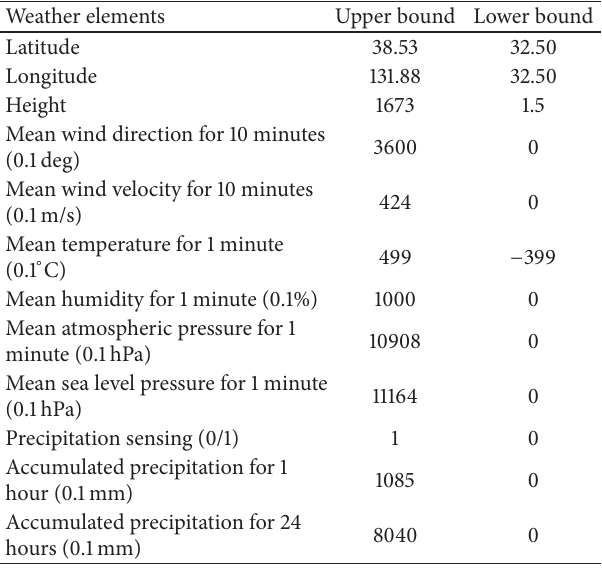
Table 2: The upper and lower bound ranges of weather data.